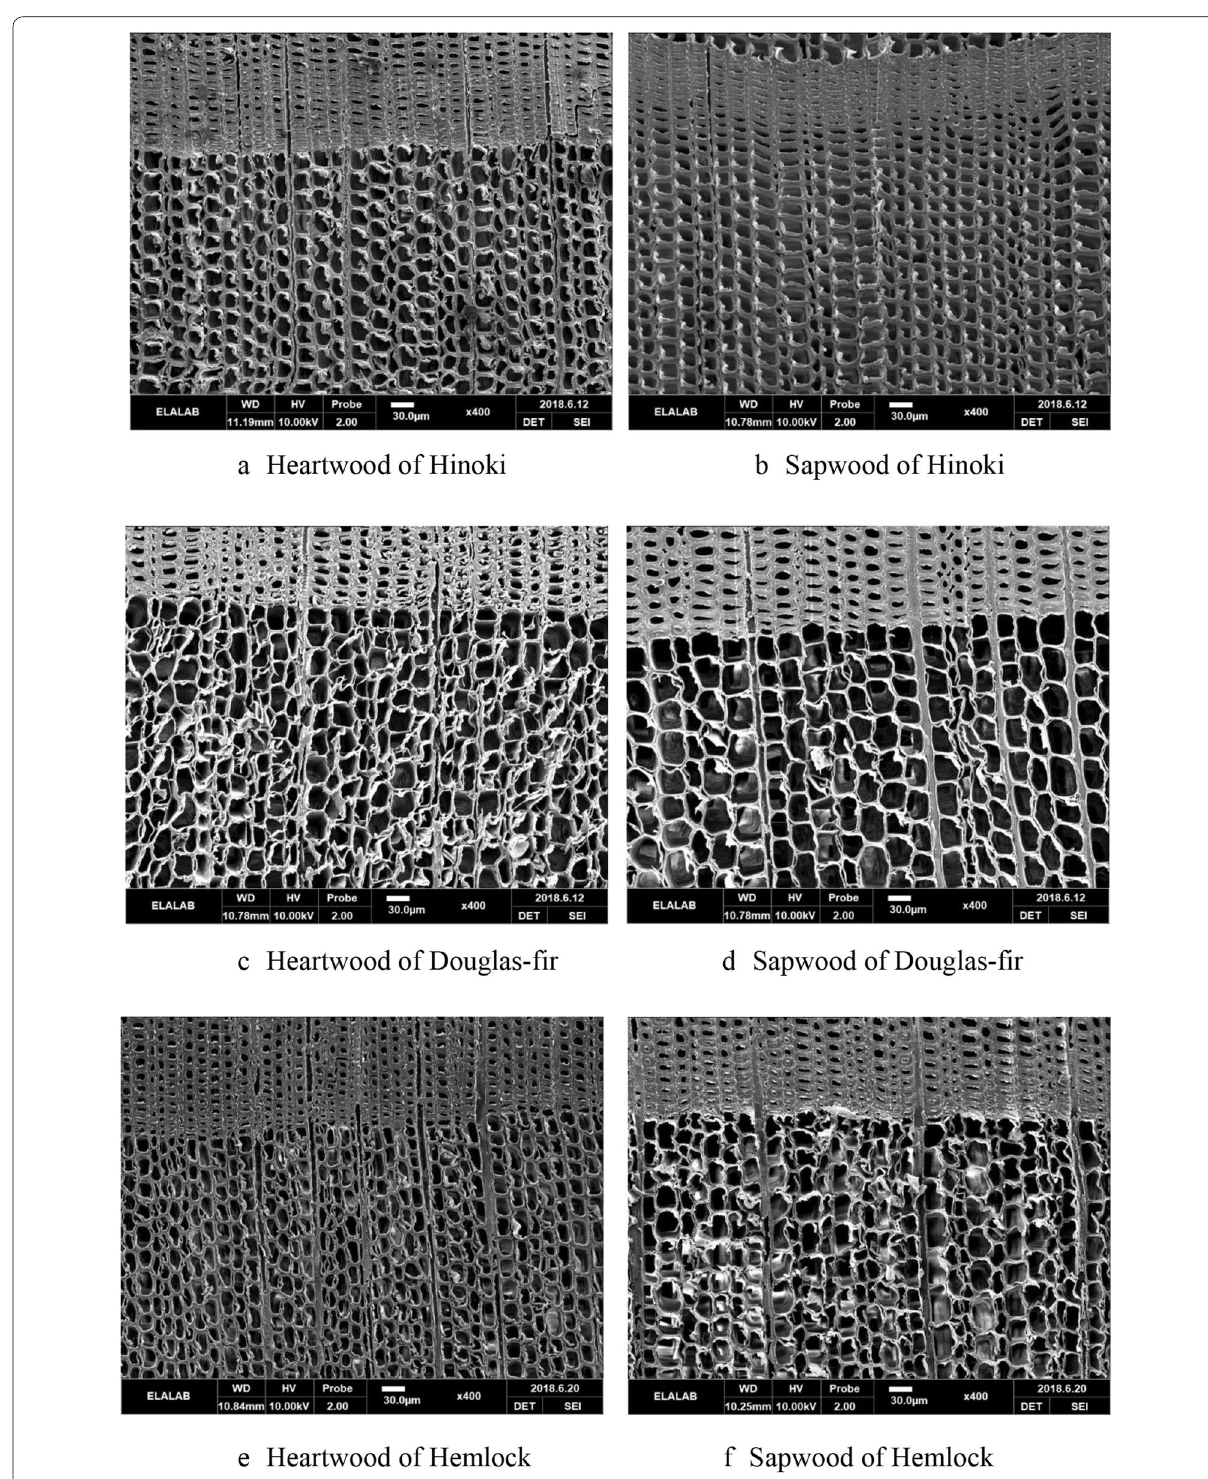
Fig. 4 SEM images of cross‑sections in three species of